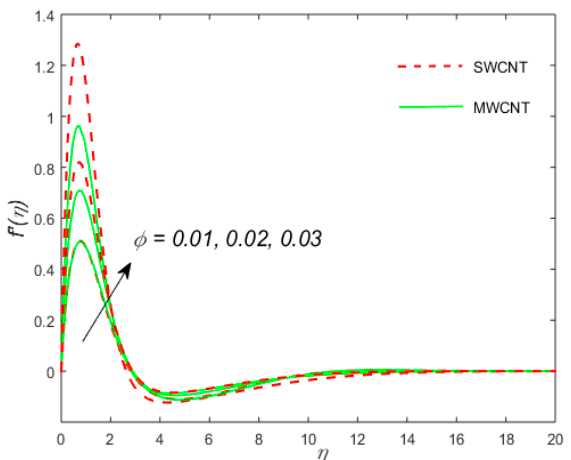
Figure 2. The variation of the velocity distribution profile f’ ( η ) for the case of SWCNT and MWCNT versus the similarity variable for the distinct values of the nanoparticle volume fraction ( φ ) .